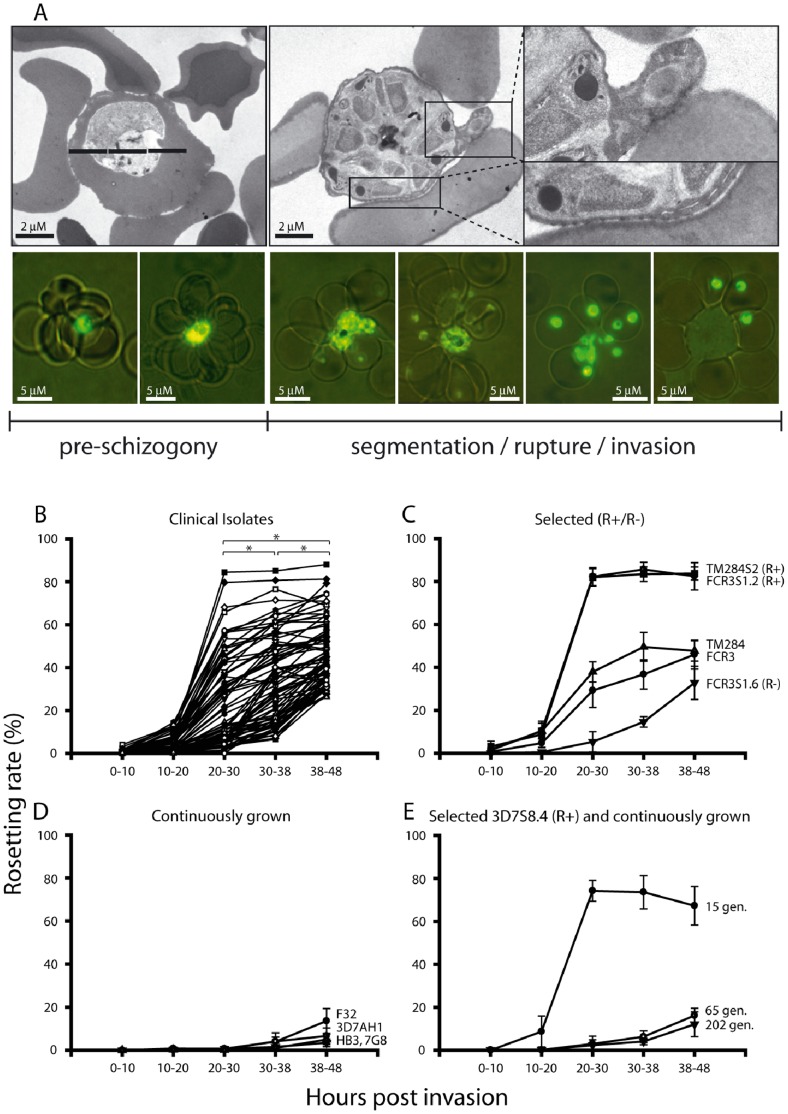
Rosette formation in clinical isolates and laboratory strains of Plasmodium falciparum.(A) Transmission electron micrographs of rosette forming trophozoite stage infected erythrocytes and the frequently observed rosetting at the time of schizogony in the clinical isolate UAS29. Live cell fluorescence during the course of rosetting in the isolate UAS31 showing rosetting during schizogony with a concordant invasion of bound uninfected erythrocytes upon rupture (parasites stained using acridine-orange and fluorescing in green, imaged using a Nikon Optiphot 2 Phase Fluorescence Microscope and a Hamamatsu Color Chilled 3CCD Camera at 100 x magnification). (B) Timing of rosette formation in 76 clinical isolates expressed as number of parasitized erythrocytes binding ≥2 uninfected erythrocytes. Each rosetting rate is the mean of the rosetting found during the three first consecutive generations post thawing. Stars indicate statistically significant higher levels of rosetting rate at schizont stage (p<0.05) compared to trophozoite stage. (C-E) Timing of rosette formation in laboratory clones and strains. Long-term propagated parasite strains not selected for rosetting or cytoadhesion were HB3, F32, 3D7AH1, FCR3 and TM284. Parasite clones selected for high or low rosetting (R+/R−) by micromanipulation were FCR3S1.2 (R+), FCR3S1.6 (R−), 3D7S8.4 (R+) and TM284S2 (R+). Rosetting rates are expressed as means with error bars representing the range of the biological replicates.